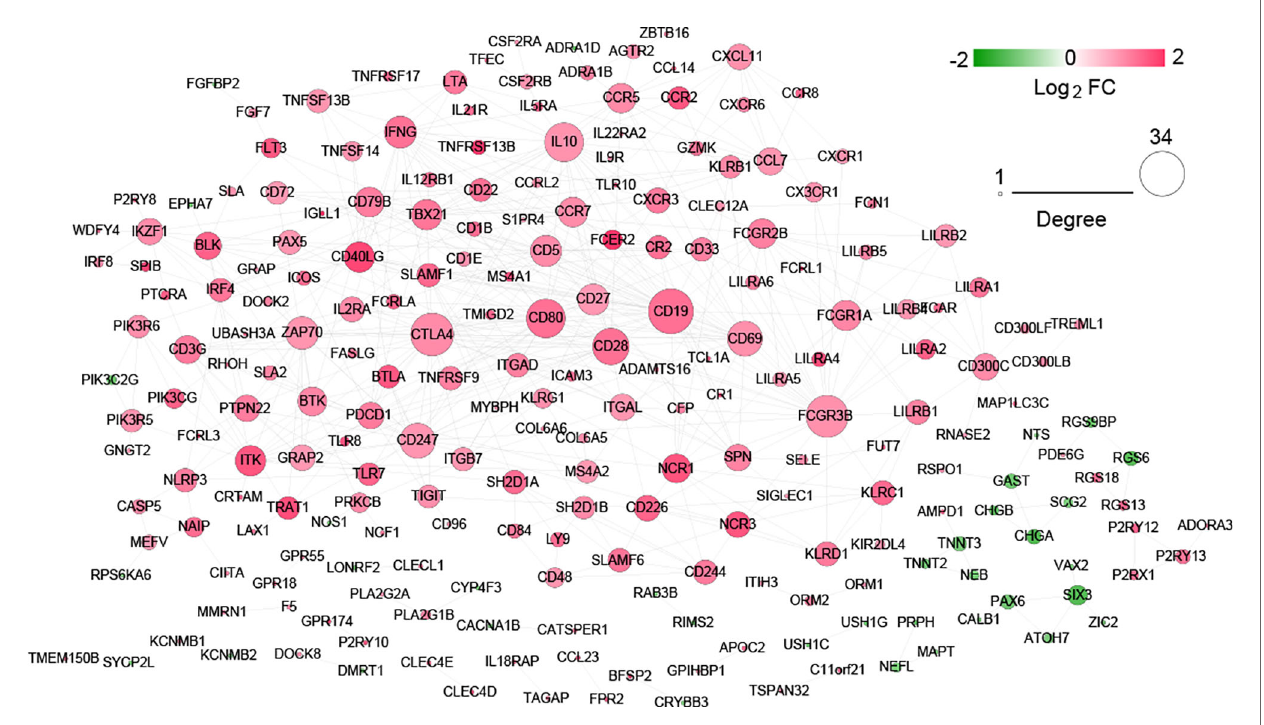
FIGURE 7 | Protein interaction network of signi fi cantly differentially expressed